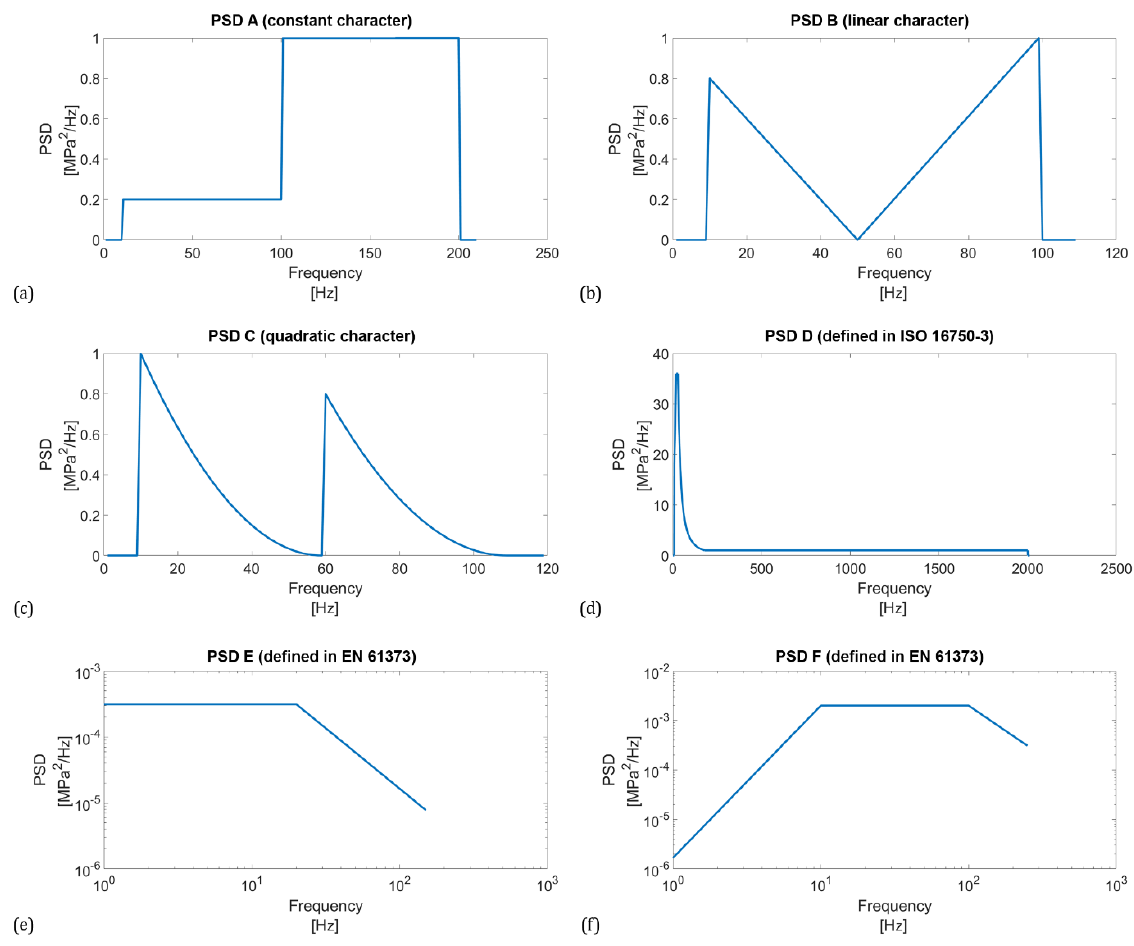
Figure 2. Synthesized PSD using constants (a), constants with linear connection (b), and constants with quadratic connection (c), standardized PSD functions according to ISO 16750-3 (d) and EN 61373 (e)-(f).